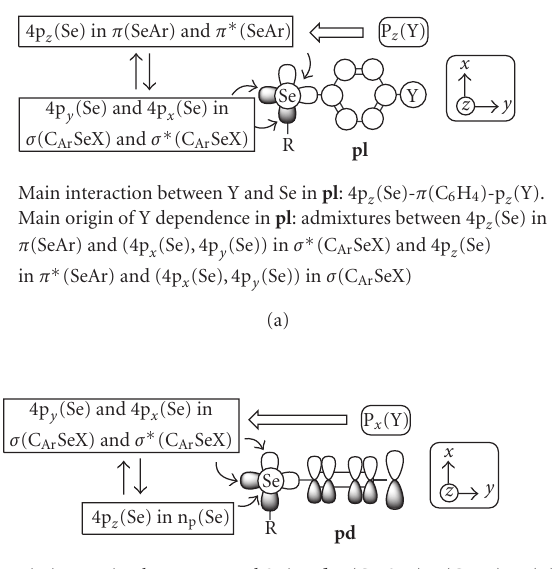
Figure 6: Plot of δ (Se: 7 ) SCS versus δ (Se: 2 ) SCS, 213K